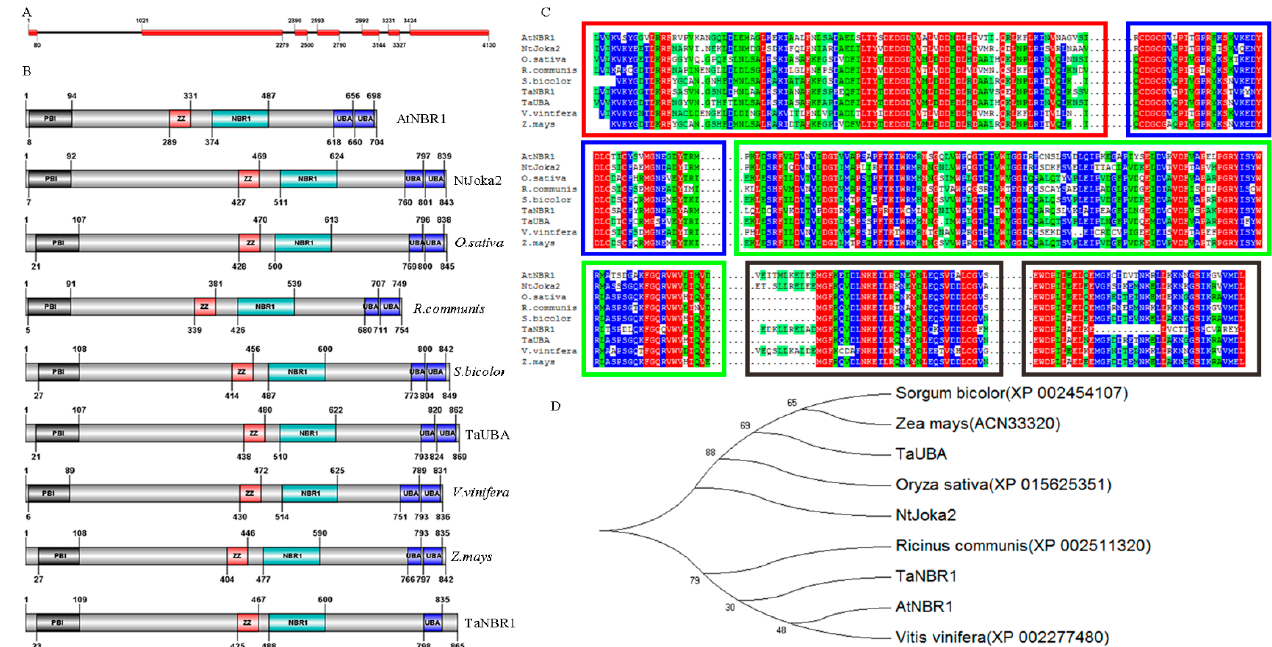
Figure 1. The TaNBR1 gene structure, multiple alignments, and phylogenetic relationships in different species. ( A ) Genomic structure of TaNBR1 , where the exons are indicated by red boxes and the introns by lines. The numbers represent the locations of the exons and introns. ( B ) The schematic diagram of the amino acid structure of NBR1 homologous genes in plants. ( C ) Multiple alignments of conserved domains in TaNBR1 and other related NBR1 homolog proteins in Oryza sativa (XP – 015625351), Aegilops tauschii (XP – 020187605.1), Zea mays (ACN33320), TaUBA (ABB18390), Vitis vinifera (XP – 002277480), and Sorgum bicolor (XP – 002454107). The alignment was performed using DNAMAN software. The conserved PB1 domain is marked with a red box, the ZnF–ZZ domain is indicated by a blue box, the NBR1 domain is shown by a green box, and the ubiquitin-associated (UBA) domain is shown by a black box. ( D ) The phylogenetic relationships of the full-length TaNBR1 and its closely related NBR1 in other plants. The cladogram was constructed using MEGA6.0